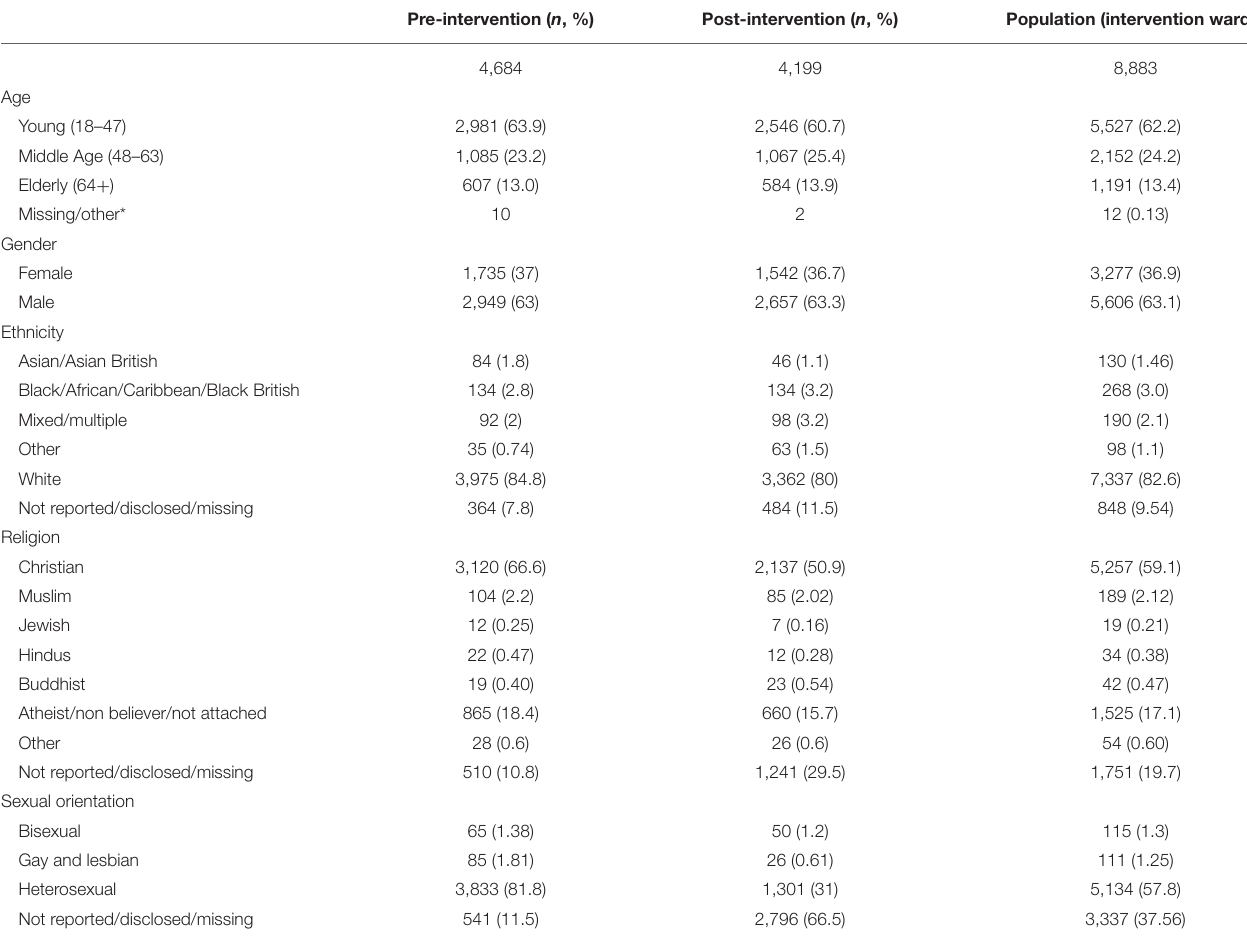
TABLE 1 | Patients’